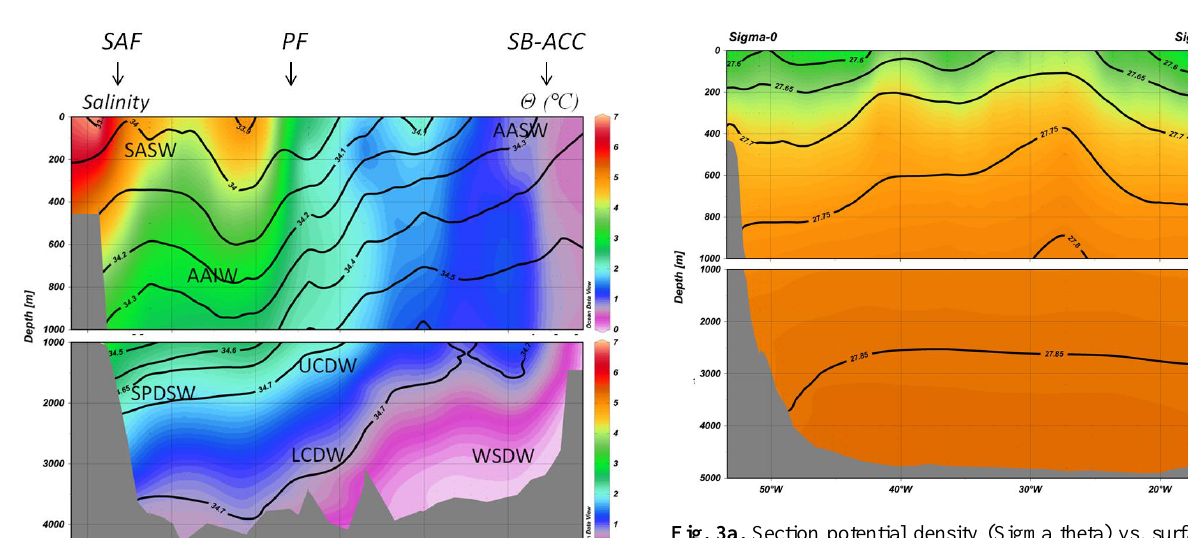
Fig. 3a. Section potential density (Sigma theta) vs. surface refer- ence level (Sigma-0) of the of the Weddell Sea